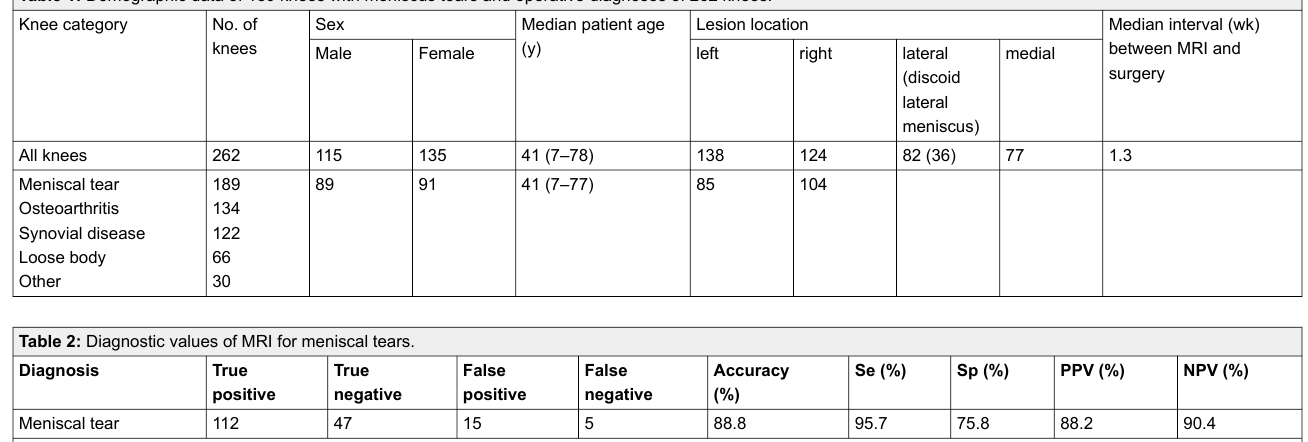
Table 1: Demographic data of 189 knees with meniscus tears and operative diagnoses of 262 knees.